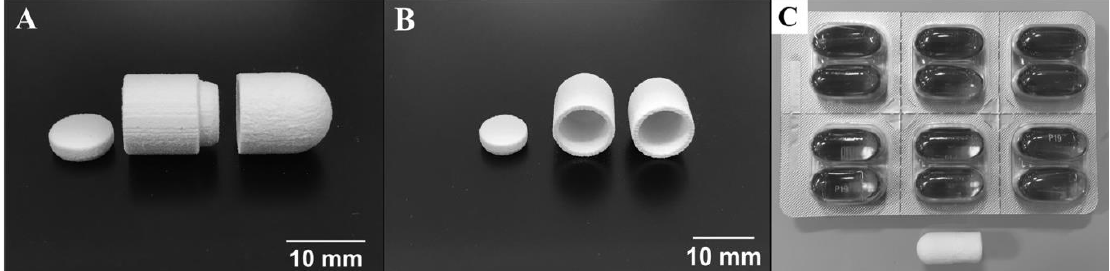
Figure 6. Multi-compartment preform tablet. ( A ) Side view of the three pieces constituting the preform tablet. From left to right, top cap, top compartment, and bottom compartment. These pieces were manufactured by powder-bed 3D printing using as binder DI water with 5% ethanol and 0.25% Tween 80. The powder utilized for their construction was calcium sulfate. Each of the two wells have a 250 µL capacity. ( B ) Front view of the preform tablet fabricated. ( C ) Comparison between the assembled version of the preform tablet and commercially available gel capsules.